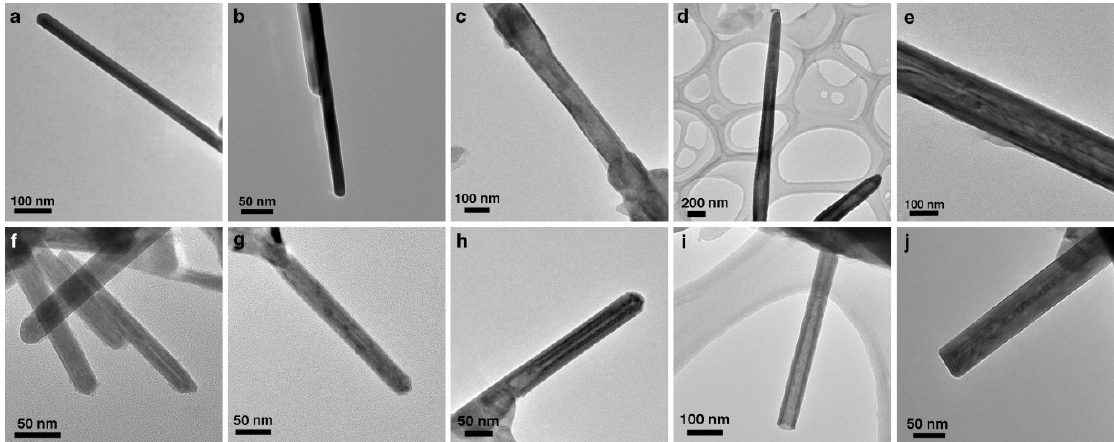
Figure 3. TEM images, ( a ) MoO (1) nanowhisker obtained after the synthesis 3− x (solar ablation for 30 s); ( b ) MoO (2) nanowhisker a year after the synthesis; 3− x ( c – e ) MoS (3) nanotubes after 30 min, 1 and 2 h of H S annealing, respectively, with 2 2 MoO nanowhiskers as a precursor; ( f ) MoS (1) nanotubes after the synthesis (solar 3− x 2 ablation for 10 min); ( g ) MoS (2) nanotube a year after the synthesis, ( h – j ) MoS (4) 2 2 nanotubes after 30 min, 1 and 2 h (H S) annealing, respectively, with MoS (2) nanotubes 2 2 as a precursor.